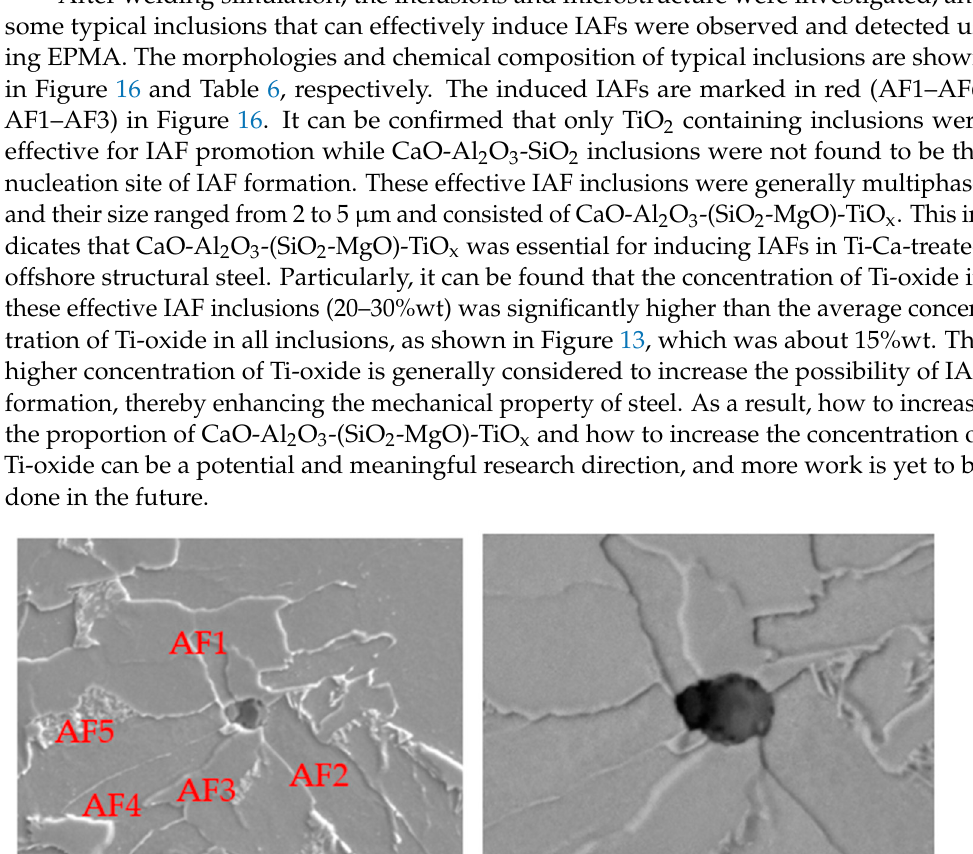
Figure 16. The morphologies of three typical inclusions after welding simulation. Table 6. The chemical composition of typical inclusions after welding simulation. No. 1.0 To clearly identify different phases in these multi-phased inclusions and thoroughly clarify the formation mechanisms, mapping scanning of FE-SEM was used for detecting the elementary distribution of effective inclusions that induced IAFs (inclusion A, B, and C). The results are shown in Figures 17–19.